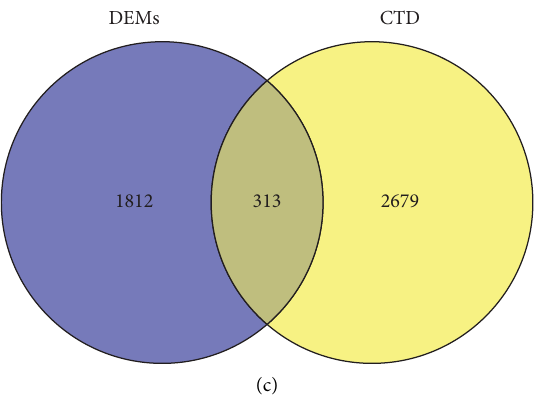
Figure 1: Identifcation of diferentially expressed lncRNA (DELs) and diferentially expressed mRNAs (DEMs) in Duchenne muscular dystrophy (DMD). (a) Volcano plots of DELs and DEMs in DMD based on the thresholds of false discovery rate (FDR) < 0.05 and |log 2 fold change| > 1. Blue and red spots represent downregulated and upregulated DELs/DEMs, respectively. (b) Bidirectional hierarchical clustering heatmap of DELs (upper) and DEMs (lower). (c) A Venn diagram of DEMs and DMD-related genes identifed in the comparative toxicogenomics database (CTD) with the inference score > 3 set as the